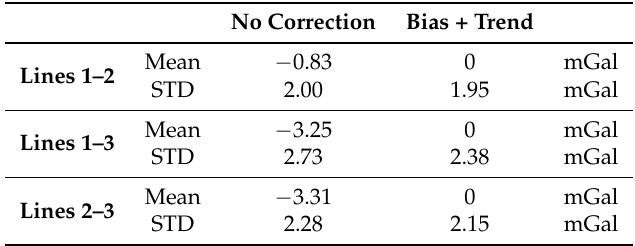
Table 5. Mean and standard deviation of the difference in gravity estimates for the three repeated lines along the JAV-KAGA profile. The difference was formed from the profiles directly and by first removing a bias and linear trend from each